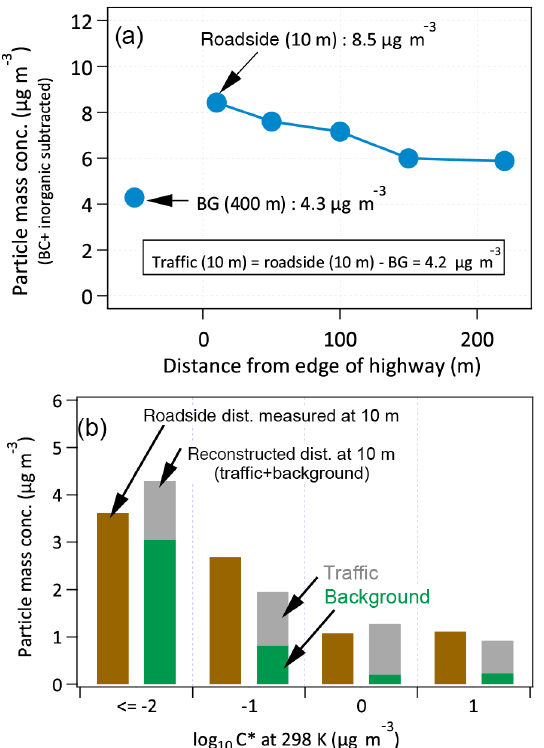
Figure 8. Comparison of measured roadside volatility distribution (at 10m) with a reconstructed distribution using traffic and back- ground contributions. Analysis conducted using an example data set from a transect measurement on 12 June 2015 (summer), with the wind consistently coming off the highway. (a) Measured up- wind (background) and downwind concentrations of particle mass loading as a function of distances from the highway. (b) Compar- ison of measured roadside volatility distribution (at 10m) with the reconstructed distribution using laboratory-measured POA volatil- ity distribution from May et al. (2013a) as representative of traffic particles and our measured volatility distribution at our most down- wind location (220m) as representative of background